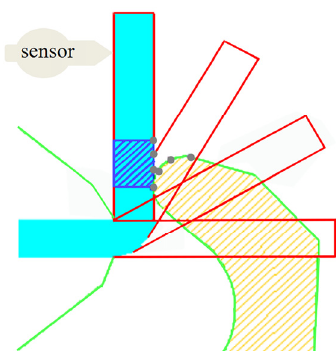
Figure 12. Sensor schematic in the springback test.